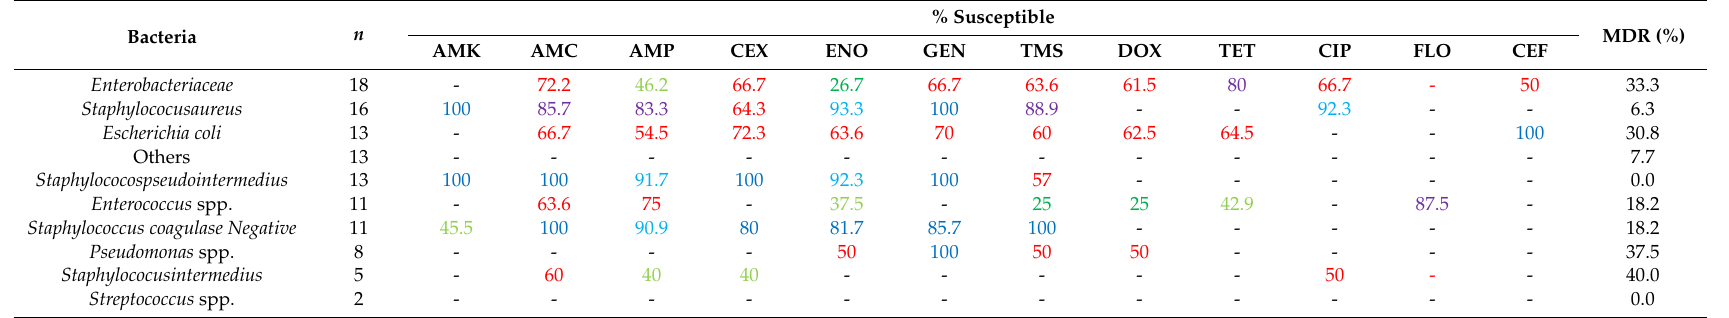
Table 4. Antibacterial susceptibilities in bacteria isolated from clinical samples of cats